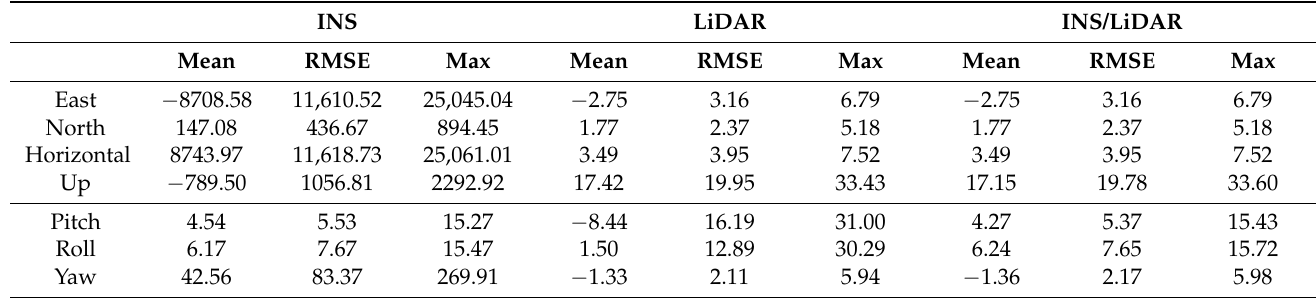
Figure 11. Complete GNNS signal outage: errors of attitude angles (roll, pitch, and yaw). Table 2. Complete GNNS signal outage—position (m) and attitude (deg) error